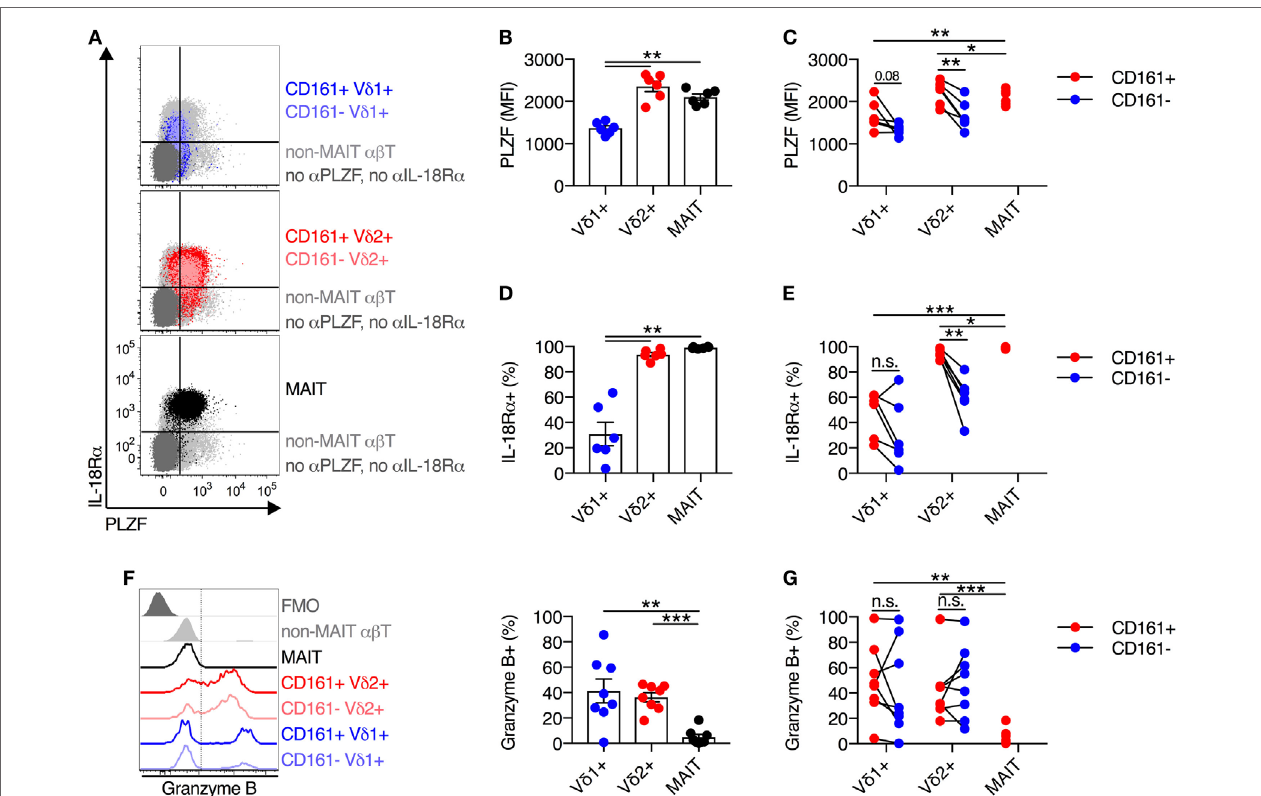
FigUre 2 | V δ 2 + γδ T cells express high levels of IL-18R α and PLZF. (a) Representative FACS plots for co-expression of PLZF and IL-18R α on CD161 + or CD161 − V δ 1 + γδ T cells and V δ 2 + γδ T cells, and mucosal-associated invariant T (MAIT) (V α 7.2 + CD161 ++ ) cells. Non-MAIT αβ T cells are included as a reference population, and cells not stained with α PLZF or α IL-18R α antibodies are included as a control. (B) Group averages for expression of PLZF, measured by mean fluorescence intensity (MFI). (c) MFI of PLZF segregated by CD161 expression for each cell subset. (D) Group averages for expression of IL-18R α , measured by percent expression. (e) Expression of IL-18R α segregated by CD161 expression for each cell subset. (F) Representative FACS plot and group averages for expression of Granzyme B. Non-MAIT αβ T cells are included as a reference population, and cells not stained with α Granzyme B antibodies (FMO) are included as a control. (g) Expression of Granzyme B segregated by CD161 expression for each cell subset. Mean ± SEM. Symbols represent individual donors ( N = 6–8), representative of two independent experiments. *** P < 0.001; ** P < 0.01; * P < 0.05. Repeated measures paired ANOVA with correction for multiple comparisons (B,D,F) and paired T test (c,e,g)